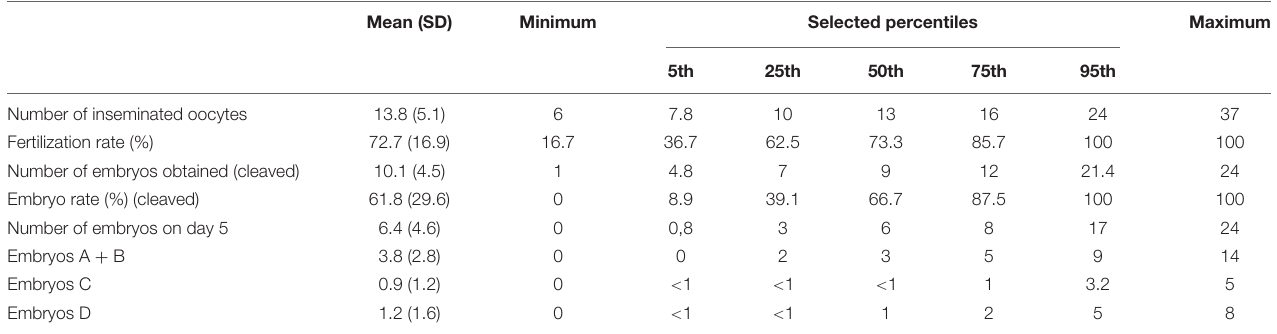
TABLE 5 | Summary statistics for embryo development and quality from oocytes of healthy women undergoing ovarian stimulation as part of their participation in an oocyte donation program ( n =